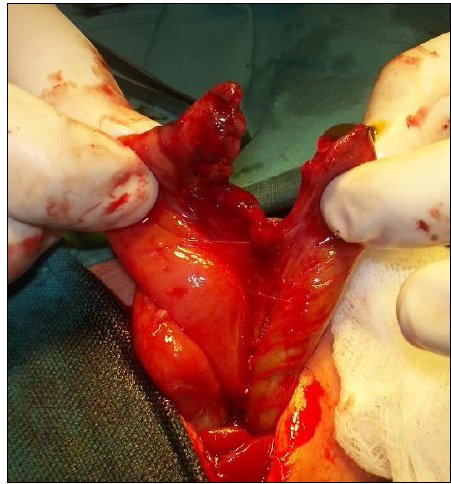
Figure 2: 7cm of jejunum (jejunal atresia) and 6cm of sigmoid colon (colonic